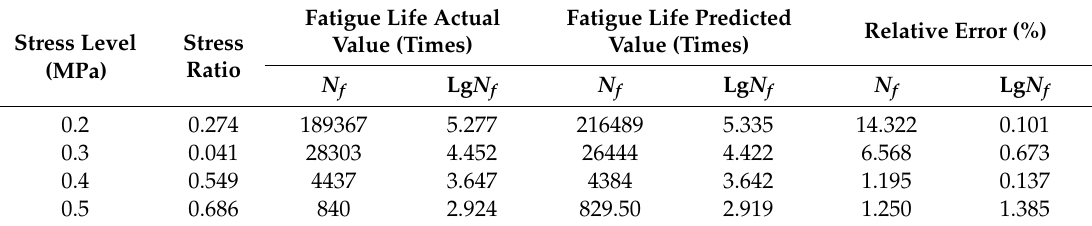
Table 10. The fatigue life predicted results by using GA-BPNN.